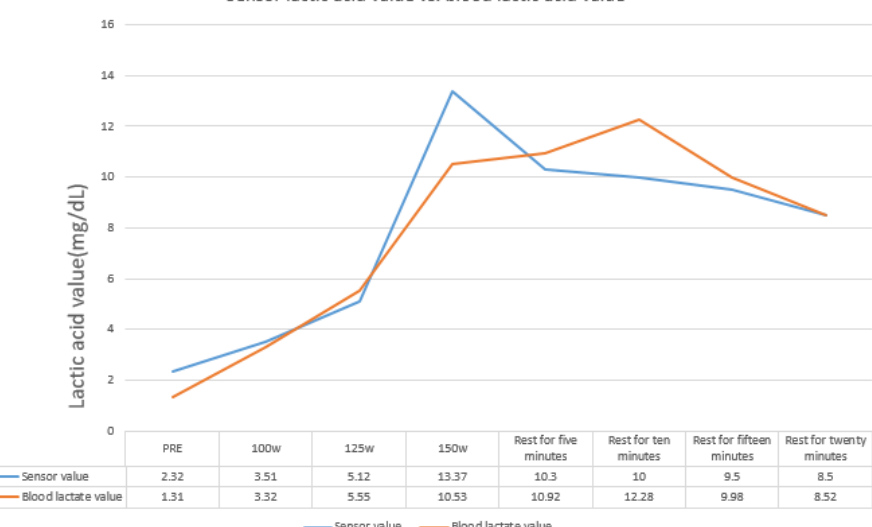
Table 2. The subjects ’ basic information, body composition, and thicknesses of thigh and calf se- bum.